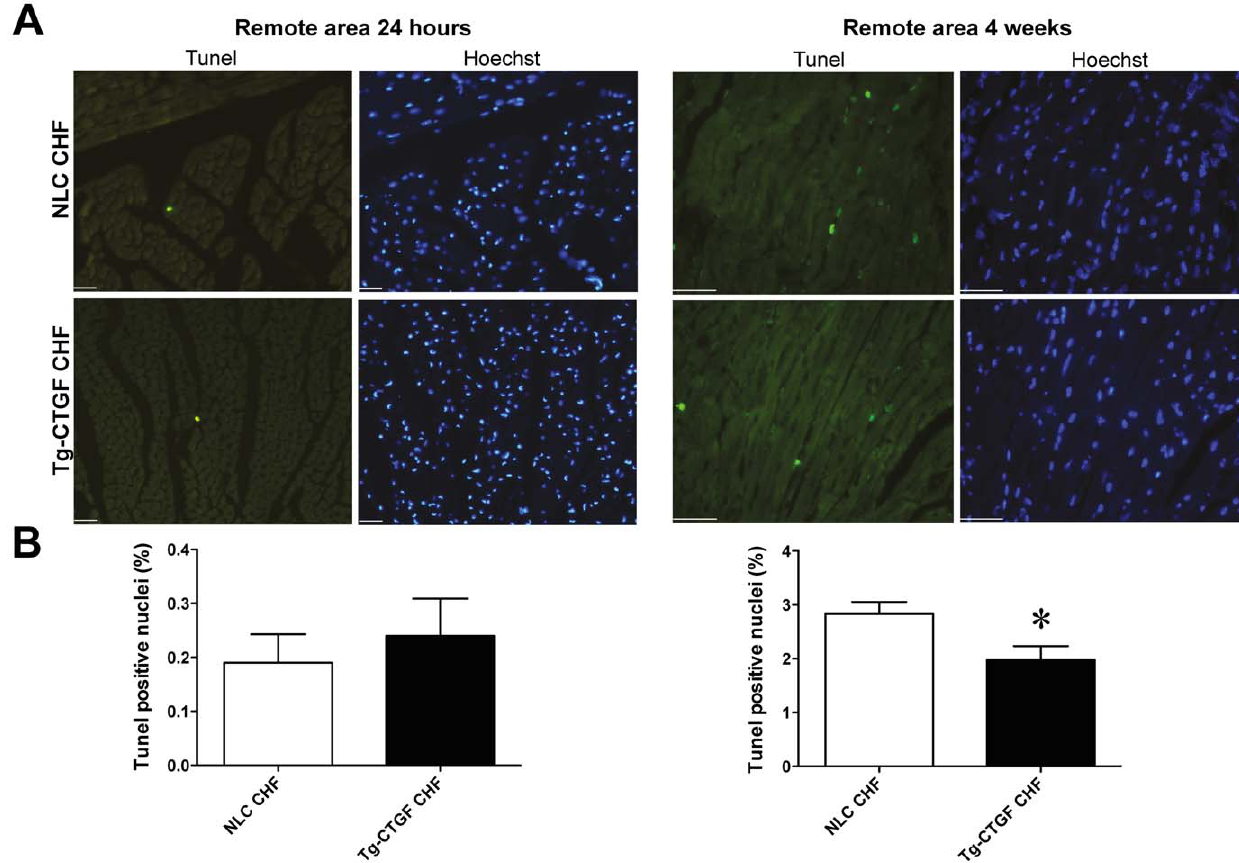
Figure 5. Morphometric analysis of myocardial cells undergoing apoptosis in NLC and Tg-CTGF mice after MI. A. Representative photomicrographs of myocardial sections subjected to staining of cells undergoing apoptosis in remote myocardium of NLC CHF and Tg-CTGF CHF mice 24 hours and 4 weeks after MI. Sections are stained with TUNEL assay and Hoechst as detailed in the Materials and Methods section. Size bar indicates 100 m m. B. Histograms of TUNEL positive nuclei in the remote myocardium of NLC CHF and Tg-CTGF CHF mice 24 hours and 4 weeks after ligation of LAD. Two visual fields/section and 3 sections per mice were analyzed. Data are mean 6 SEM of Tg-CTGF CHF (n=4) and NLC CHF mice (n=4). * P , 0.05 vs. NLC CHF group.